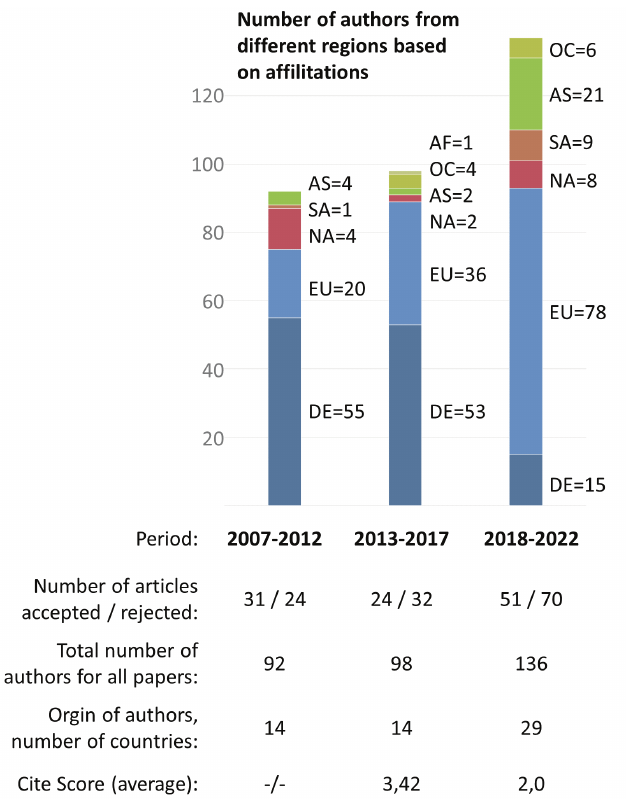
Figure 2. Overview of articles, authorship and cite score of Landscape Online across three periods. (AF= Africa, AS=Asia; EU=Europe; NA=North America; OC=Oceania; SA=South